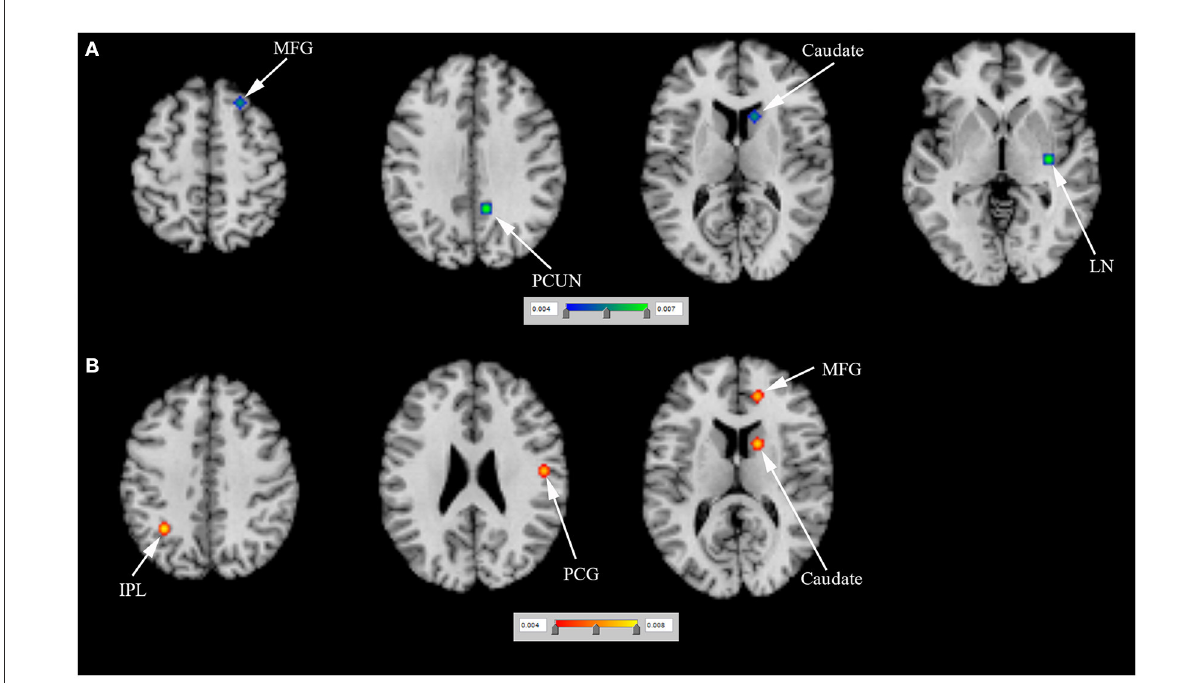
FIGURE4 (A) Reduced task-related brain activation (in blue) and (B) increased task-related brain activation (in red) in PD-ICD patients, compared to PD-no ICD. ICD, impulse control disorder; IPL, inferior parietal lobule; LN, lentiform nucleus; MFG, middle frontal gyrus; PCG, precentral gyrus; PCUN, precuneus; PD, Parkinson’s